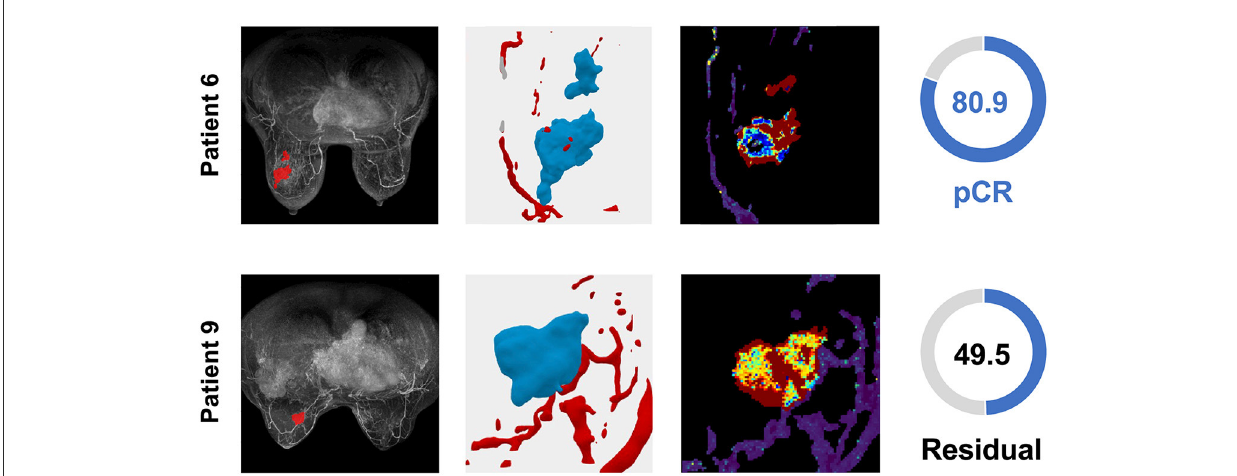
FIGURE5 TNBC patient tumors from the validation cohort demonstrate the distribution of the TumorIO biomarker and utility of the TumorIO Score in predicting pCR in response to ICI therapy. The general workflow entails analysis of patient DCE-MRIs in order to generate virtual tumors. Spatial maps of TumorIO (reflecting metabolic activity and angiogenesis) show areas of the tumor and TME contributing to the TumorIO Score . The DCE-MRI dataset and resulting virtualized tumor are shown (left and middle-left) . The heatmap (middle-right) ranges from red to blue, representing a high to low gradient of the TumorIO biomarker within each tumor. These features are inversely correlated to the IO sensitivity of a tumor. In patient 6, low metabolic activity and areas of high angiogenesis contribute to a high TumorIO Score (right) and a correct prediction of pCR. In contrast, in patient 9, high metabolic activity and relatively few areas of angiogenesis contribute to a low TumorIO Score and a correct prediction of residual disease (right) .